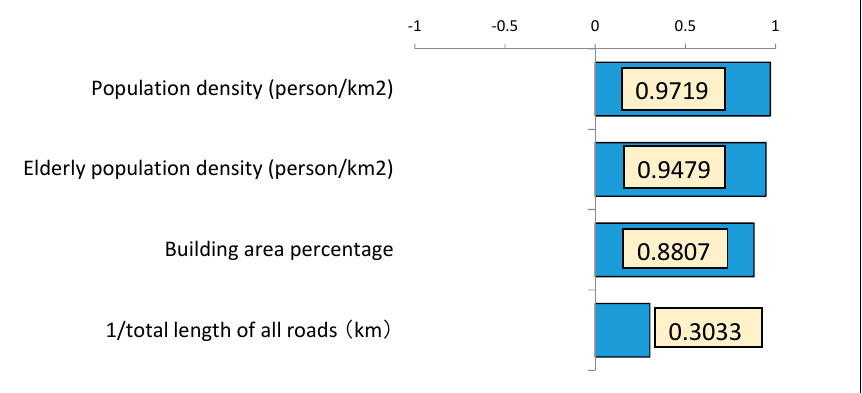
Figure 6. Principal component load of each variable in principal component 1.